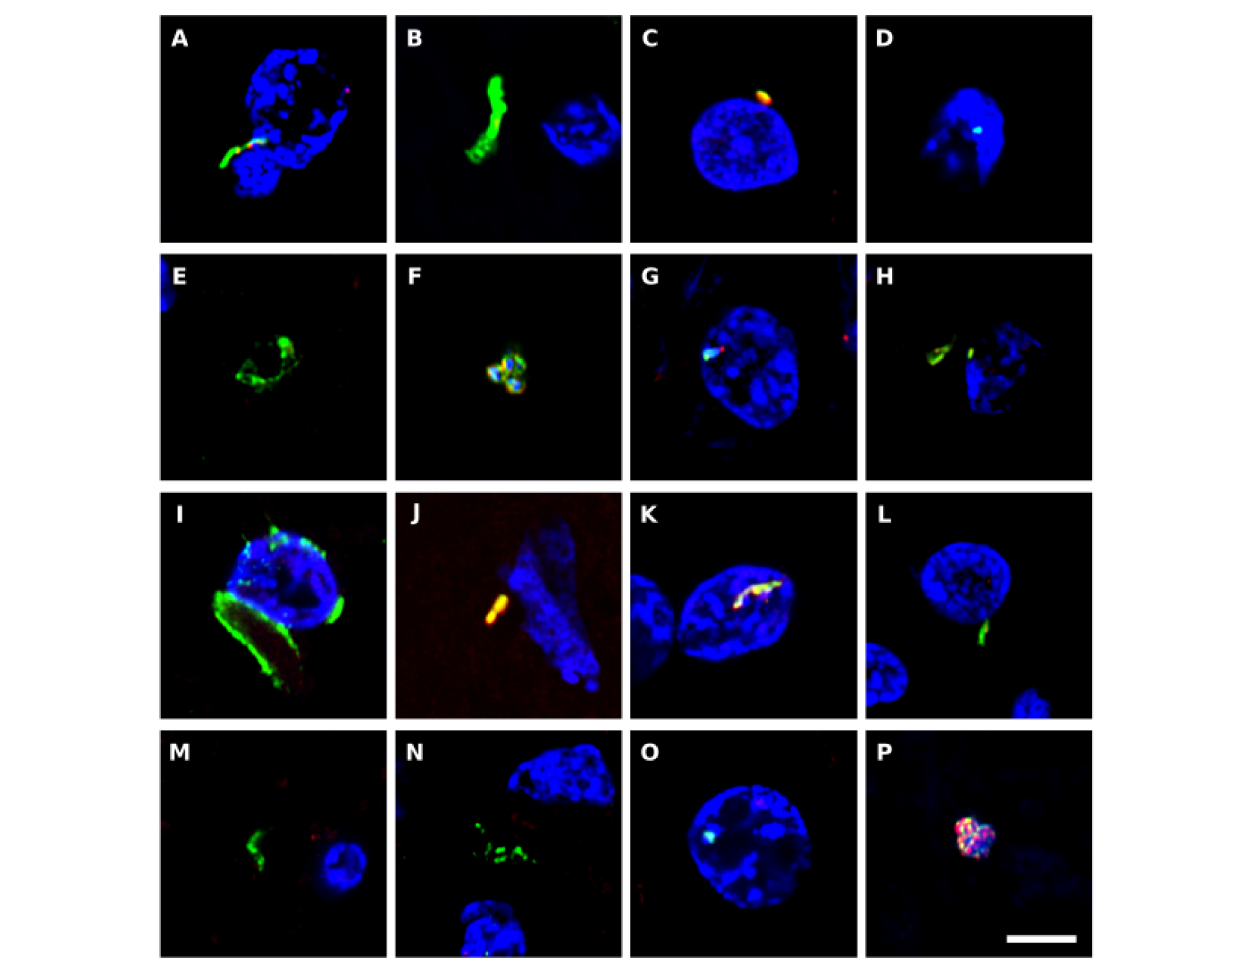
FIGURE 7 | Immunohistochemistry to detect C. pneumoniae antigens in brain tissue from ALS patients. Double immunostaining and confocal microscopy were carried out as indicated in section Materials and Methods. CNS sections were immunostained with a rabbit polyclonal C. pneumoniae antibody (green) (1:20 dilution) and a rat polyclonal anti- T. viride antibody (red) (1:20 dilution). DAPI staining of nuclei appears in blue. Scale bar: 5 µ m. (A,B) ALS2; (C,D) ALS3; (E) ALS5; (F–H) ALS6; (I,J) ALS1; (K) ALS7; (L,M) ALS8; (N) ALS9; (O) ALS10; and (P) ALS11. (A,C,F,I,K,L,P) MC section; (G,N,O) MD section; and (B,D,E,H,J,M) SC